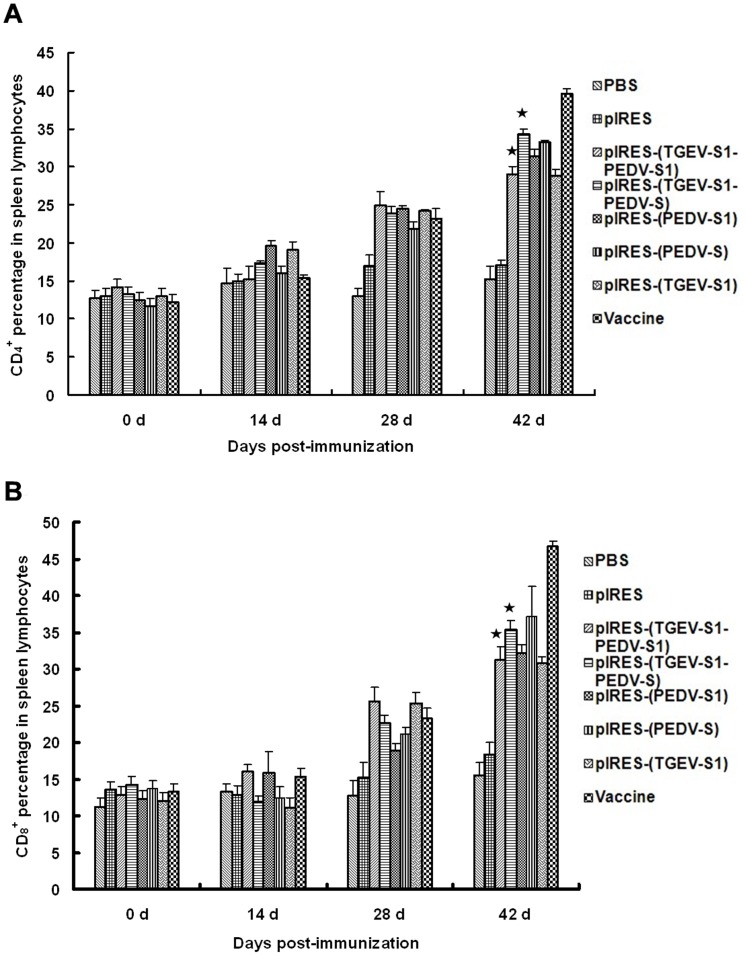
Changes in CD4
+ and CD8
+ T lymphocytes in the spleens of immunized mice.Spleen cells from mice immunized with recombinant plasmids were collected and subjected to flow cytometry to assess the numbers of CD4
+ T lymphocytes (A) and CD8
+ T lymphocytes (B). ★: p<0.01 (highly significant), compared with the PBS and pIRES groups.